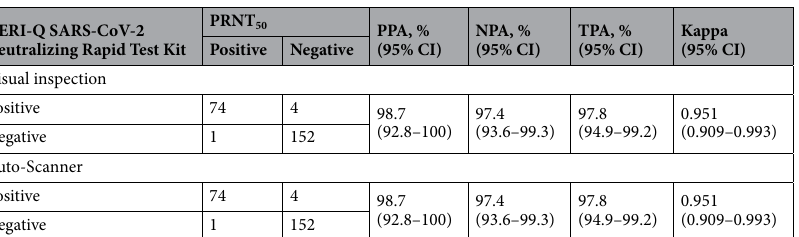
Table 2. Diagnostic accuracy of VERI-Q SARS-CoV-2 Neutralizing Detection ELISA Kit for the detection of neutralizing antibodies against SARS-CoV-2 compared to the 50% plaque reduction neutralization test. PPA positive percent agreement; NPA negative percent agreement; TPA total percent agreement; PRNT plaque reduction neutralization test.